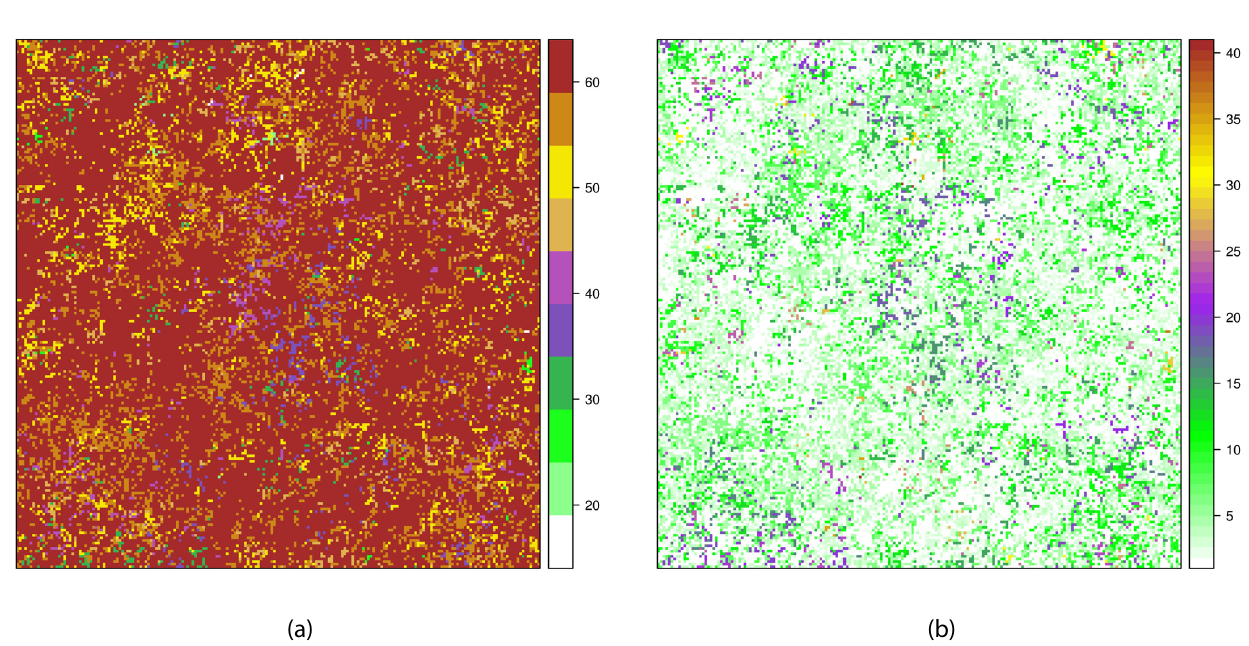
Supplementary Figure 1. Comparison of a multiespecies spatial distribution generated by a neutral model with 64 possible species. Both figures represent the same species distribution but with diferent numeric values assigned to species. ( a ) The values are assigned by the simulation program. The most abundant species have higher values and the range 1–64 represents all posible species. ( b ) Spatial Rank Surface: each species is assigned to its rank as explained in the main text: the most abundant species has the lowest value and represent valleys, rare species represent peaks. The range is lower because some species did not